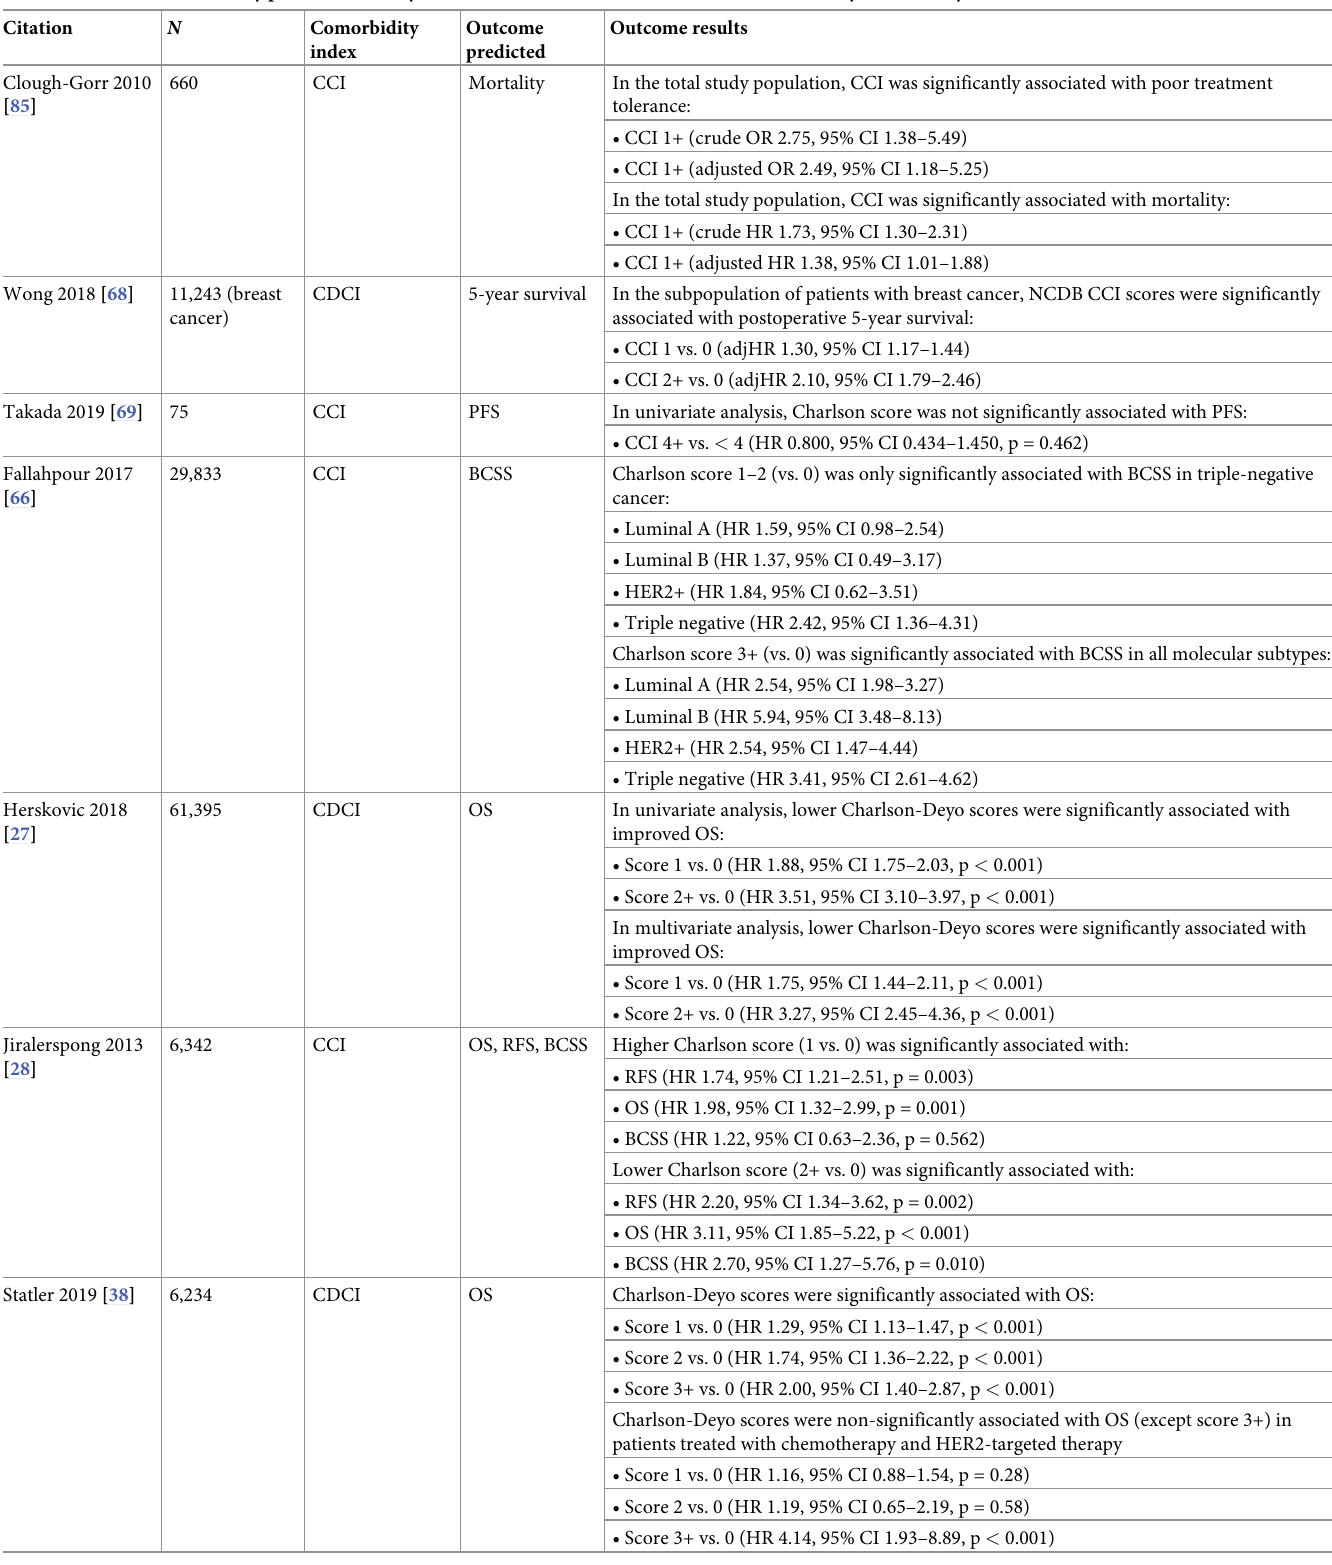
Table 4. Survival and mortality predictive validity results for breast cancer and HER2+ breast cancer by comorbidity index and outcome.